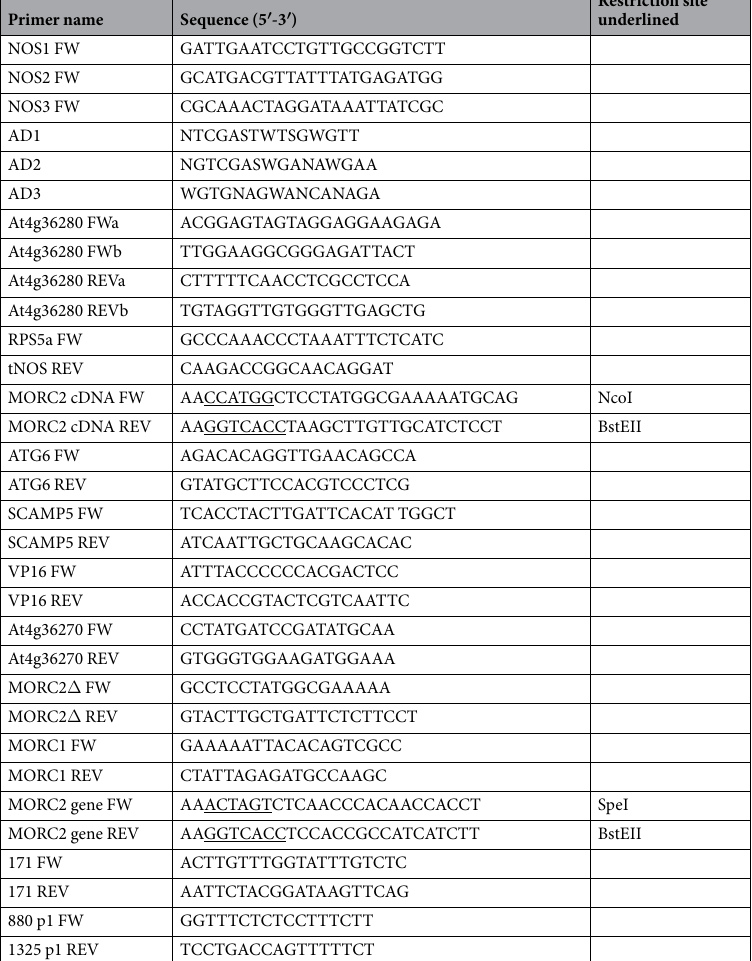
Table 2. Primers used for the genetic analysis of LCF1. Nucleotide codes: ‘N’ is any of the four bases; ‘W’ is either A or T; ‘S’ is either G or